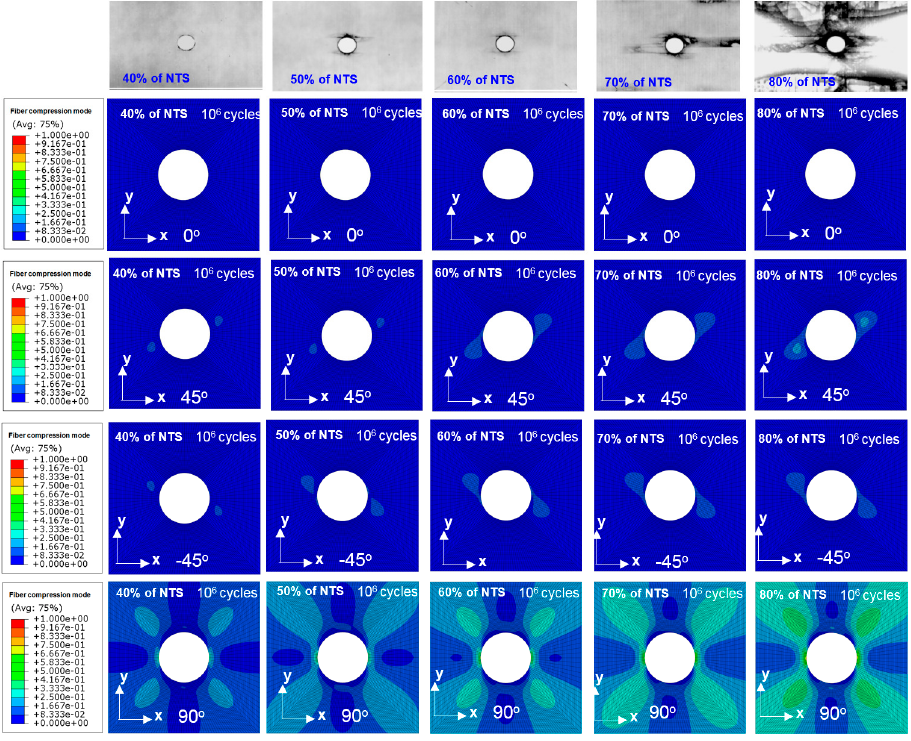
Figure 12. Matrix tension failure index after 10 6 cycles in the quasi-isotropic OHT specimen.